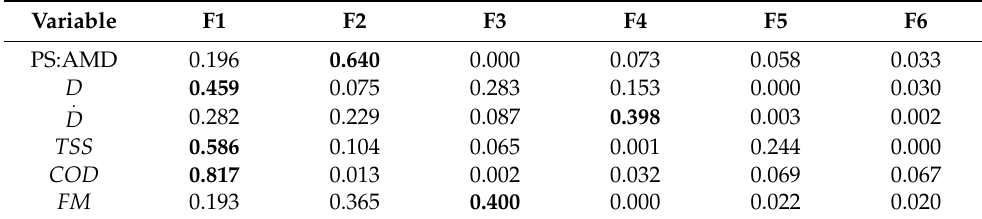
Values in bold correspond for each variable to the factor for which the squared cosine is the largest.